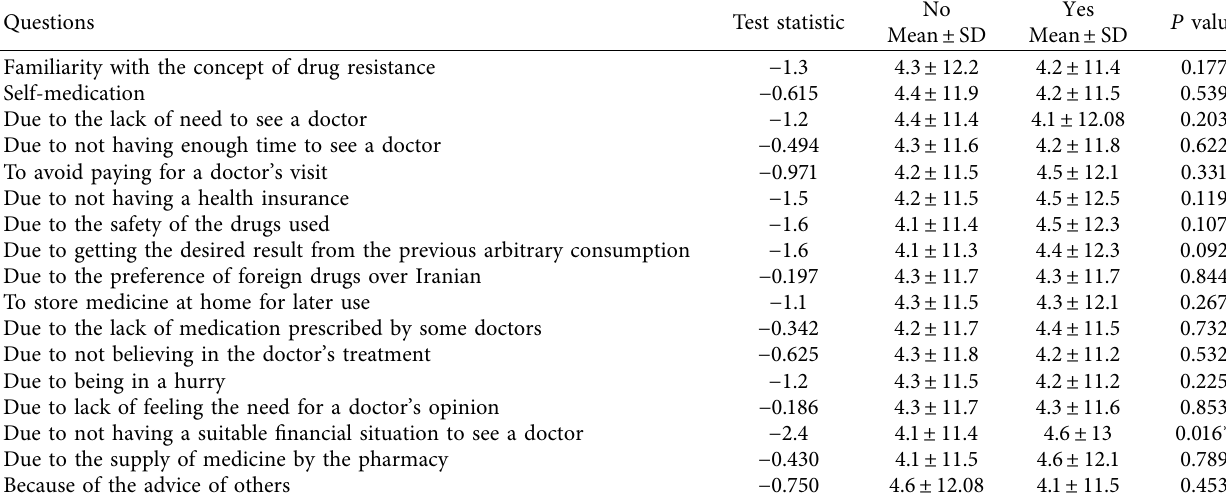
Table 4: Distribution of relative and absolute frequency of self-medication in the participants.